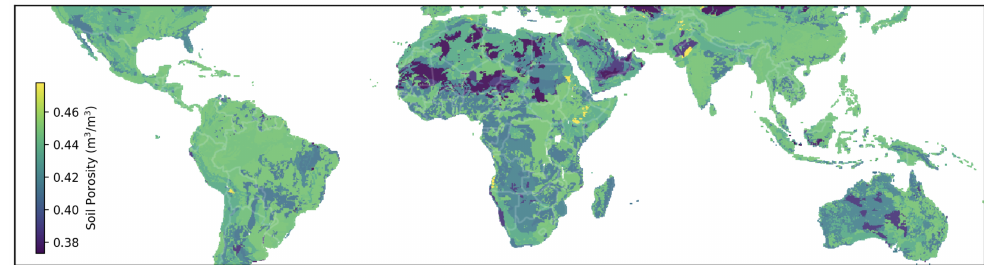
Figure 21. Map of soil porosity for measurement region indicating effective upper bound on soil moisture